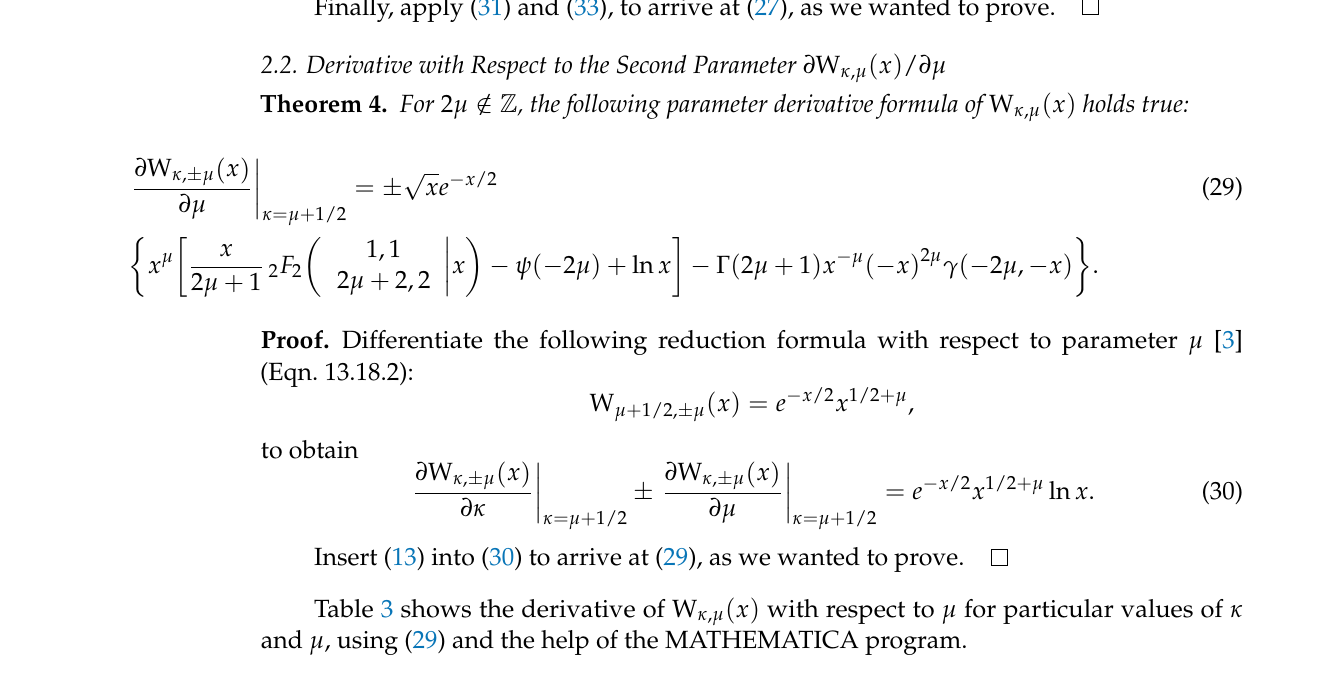
Table 3. Derivative of W κ , µ with respect to µ , by using